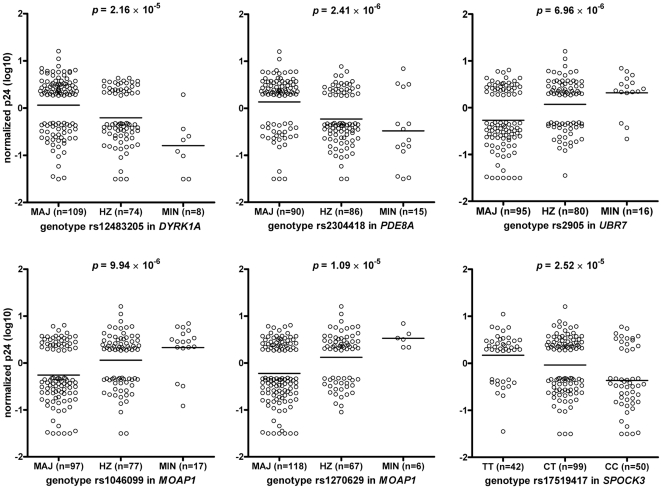
Association between HIV-1 replication in monocyte-derived macrophages (MDM) and the genotypes for the SNPs rs12483205 in DYRK1A, rs2304418 in PDE8A, rs2905 in UBR7, rs1046099 and rs1270629 in MOAP1, and rs17519417 in SPOCK3.Only donors with MDM with low (n = 95) or high (n = 96) HIV-1 replication in vitro were included in the genome-wide SNP analysis. This selection of donors with a more extreme phenotype explains the absence of circles in the middle section of the graphs. MAJ, homozygous for the major allele; HZ, heterozygote; MIN, homozygous for the minor allele.